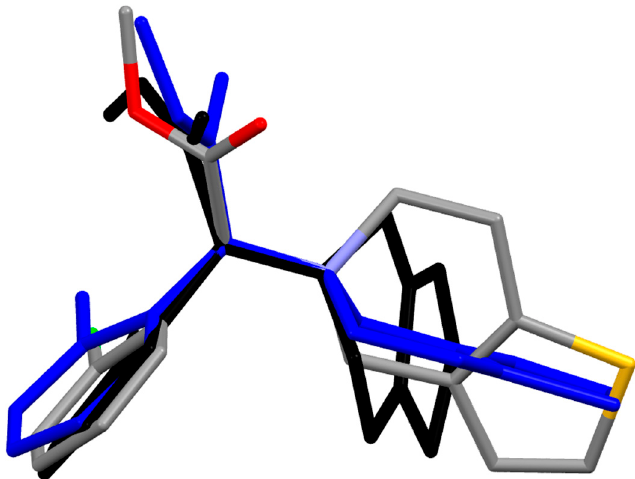
Figure 3. Molecular superimposition of the Becke3LYP-optimized molecular structure of clopidogrel (color by connected atoms), clopidogrel from the cocrystal with the cytochrome P450 2B4 active site PDB.3ME (blue) and clopidogrel from the cocrystal with the cytochrome P450 2B4 active site mutant F297A PDB.4H1N (color by connected atoms, carbon gray, oxygen red, sulfur yellow). For simplicity, the hydrogen atoms are not shown.